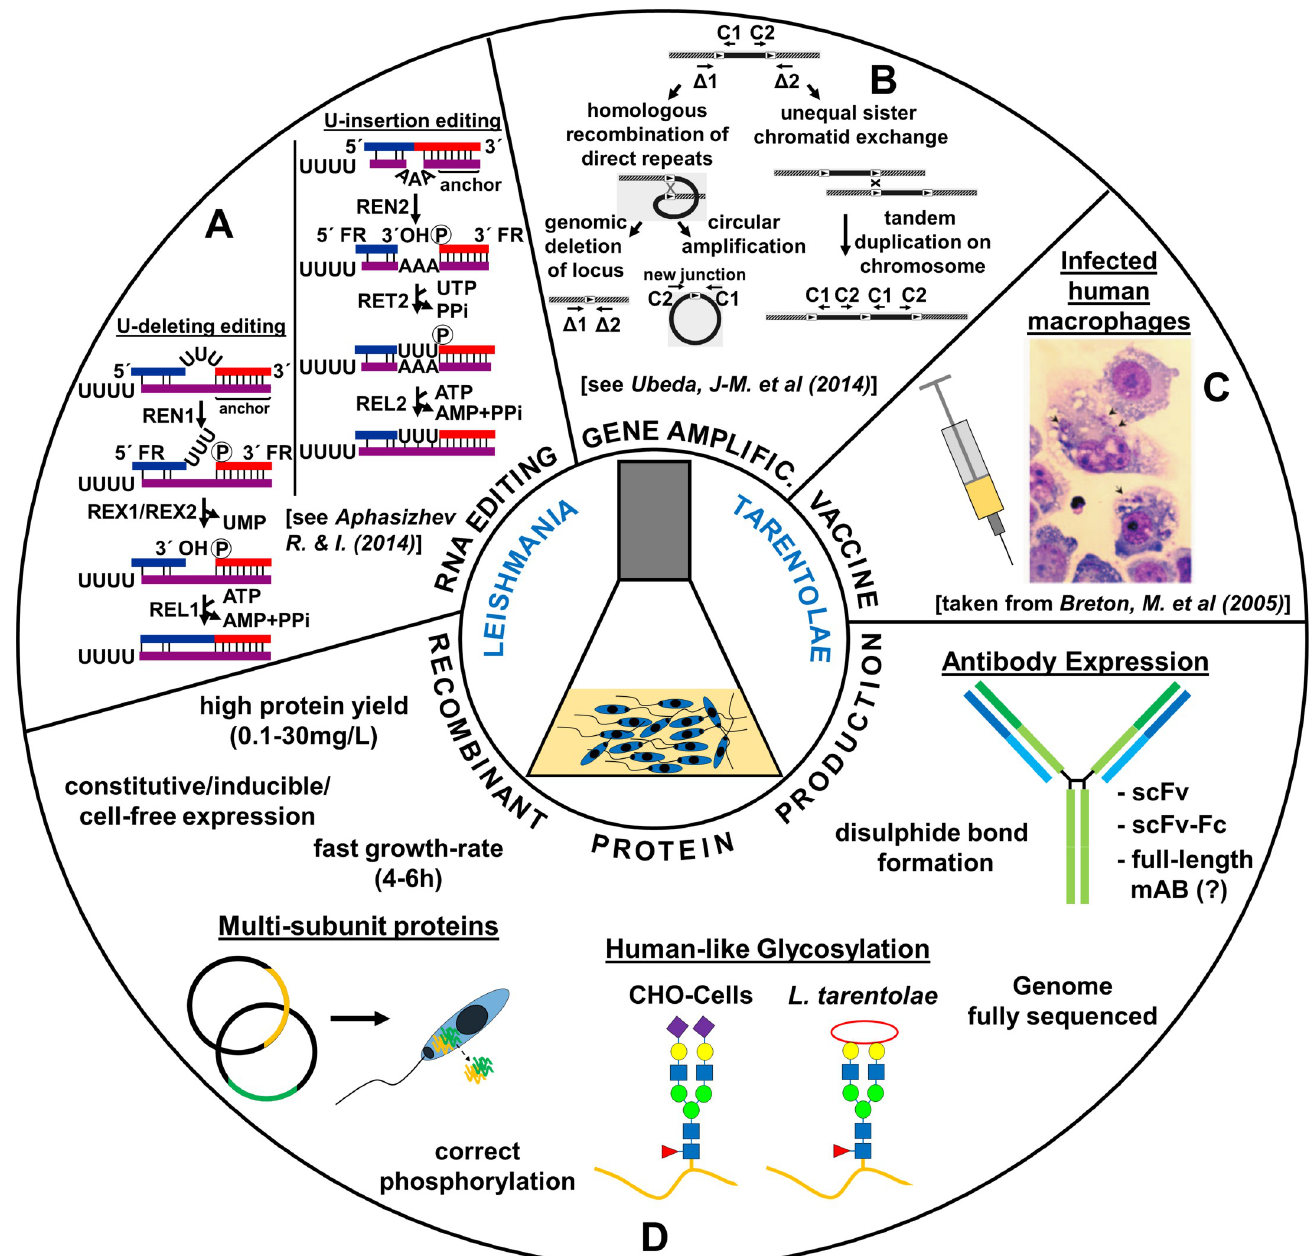
Fig 3. Biotechnological applications of the eukaryotic parasite L . tarentolae . L . tarentolae is used to study RNA editing (A), gene amplification (B), vaccine development against human-pathogenic Leishmania species (C), and recombinant (human) protein production (D). AMP, Adenosine monophosphate; ATP, Adenosine triphosphate; CHO, Chinese hamster ovary; PPi, diphosphate; REL, RNA editing ligase; REN, RNA editing endonuclease; RET, RNA editing TUTase; REX, RNA editing exonuclease; scFv, single-chain fragment variable; scFv-Fc, single-chain fragment variable fragment crystallizable; UMP, uracil monophosphate; UTP, uracil triphosphate. Partial pictures adapted from [6] for (A), [118] for (B), and [103] for (C)